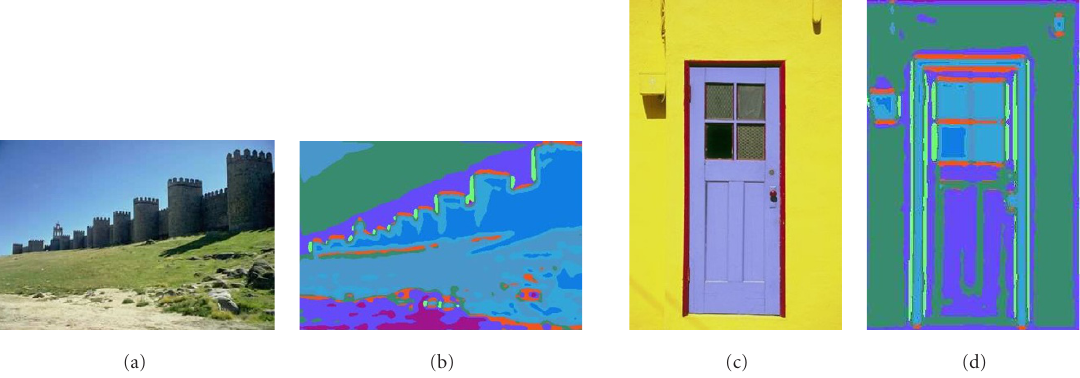
Figure 10: Two examples of images before and after quantization of the texture space by adaptive k -means in 25 classes. A gray level is randomly attributed to each texture